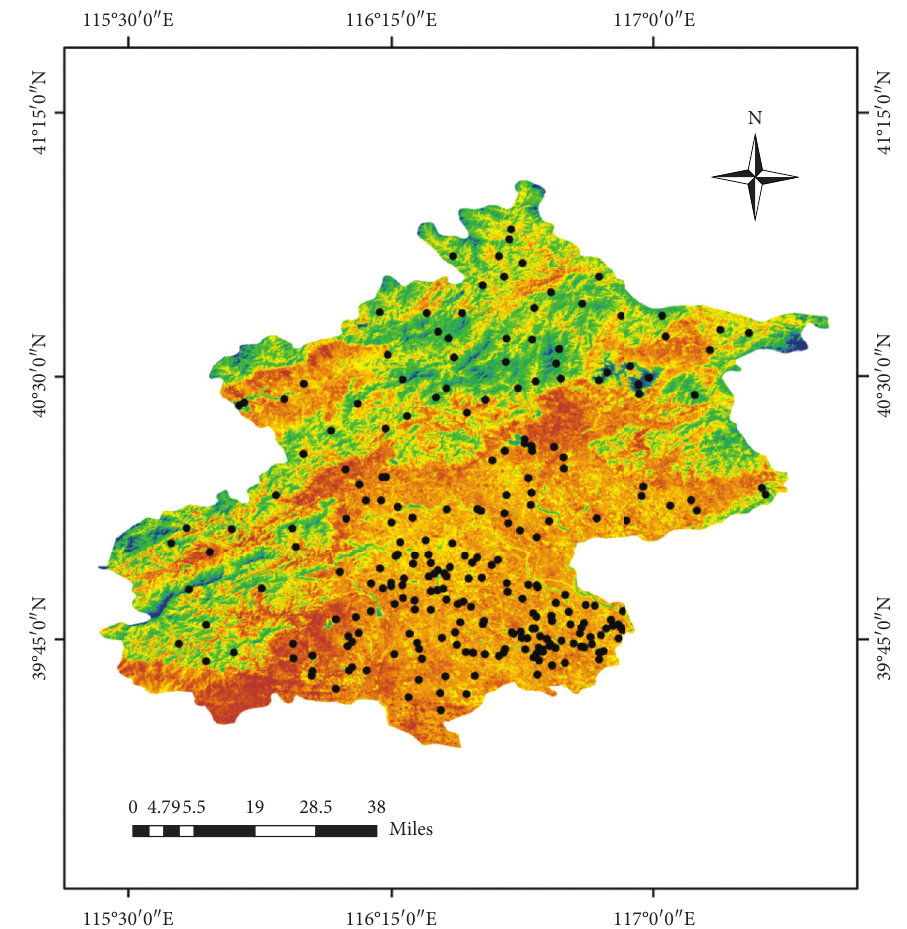
Figure 6: Distribution of selection points for predicting LST.